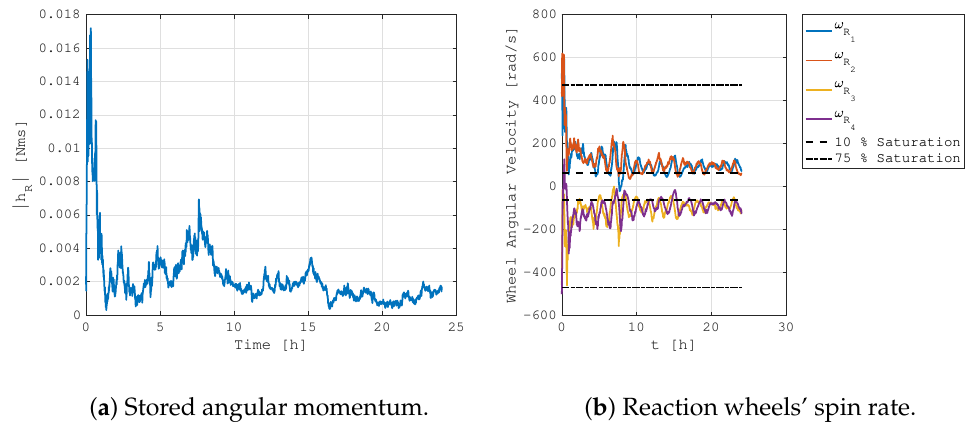
( b ) Reaction wheels’ spin rate. Figure 10. Stored angular momentum evolution in MIL simulation of nadir-pointing control.